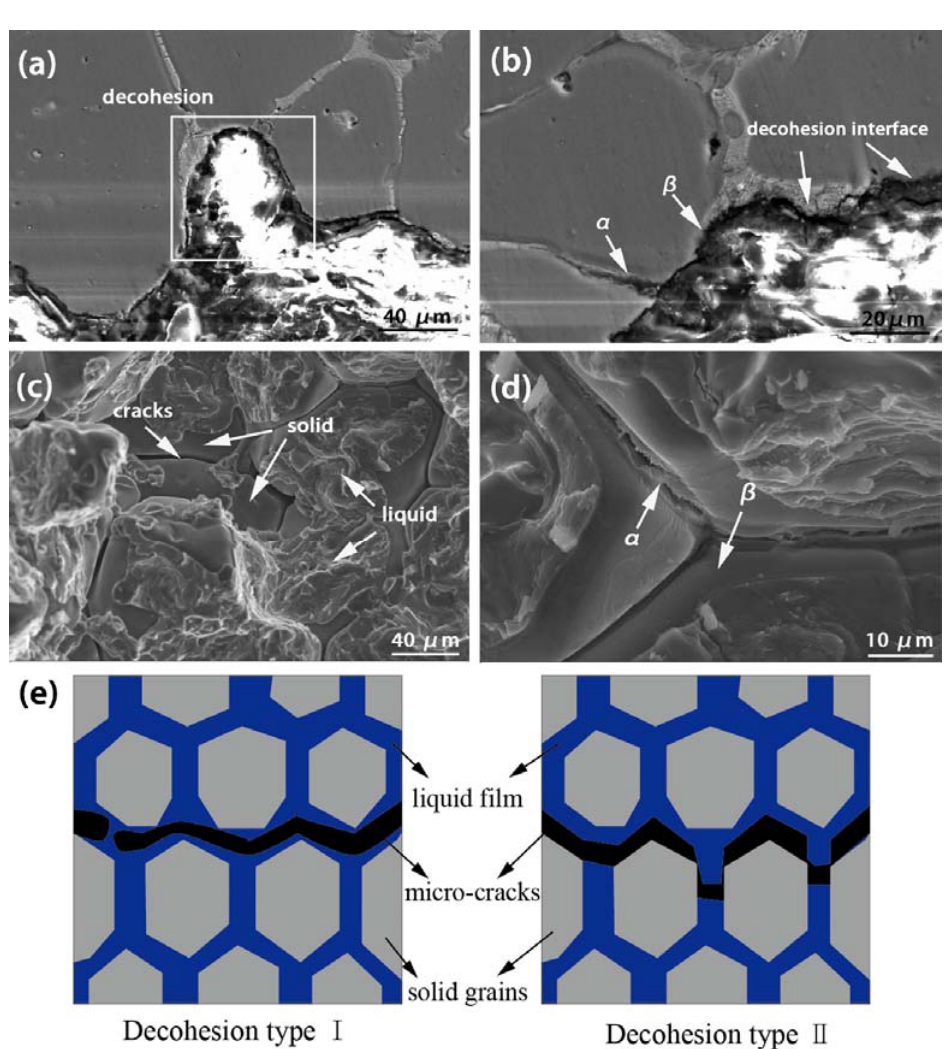
Figure 12. The SEM image of ( a , b ) fracture profiles and ( c , d ) fracture surfaces of the RAP-processed AA7075 alloy after reheating at 620 °C for 25 min; ( e ) The schematic illustration of two kinds of decohesion types (by Bolouri et al. [23]).